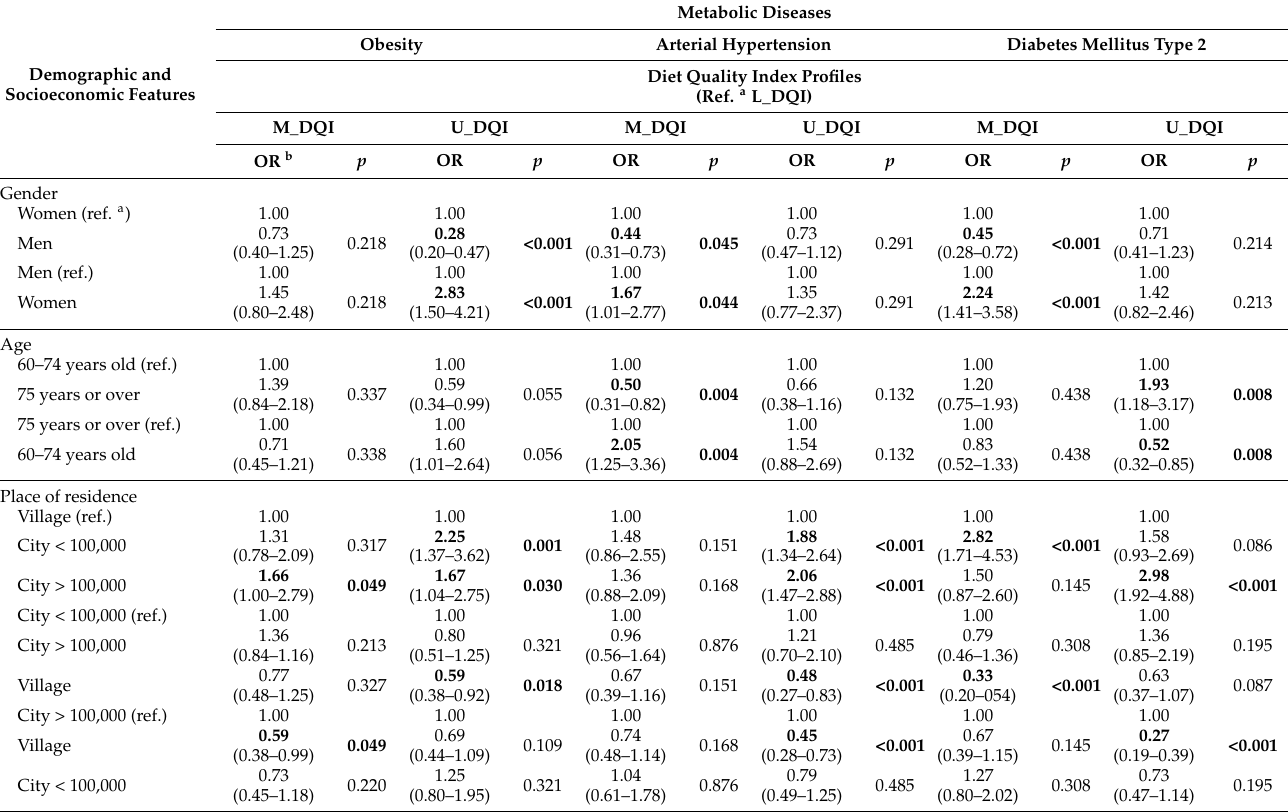
Table 4. Odds ratios for moderate- and high-diet-quality indexes for selected demographic and socioeconomic